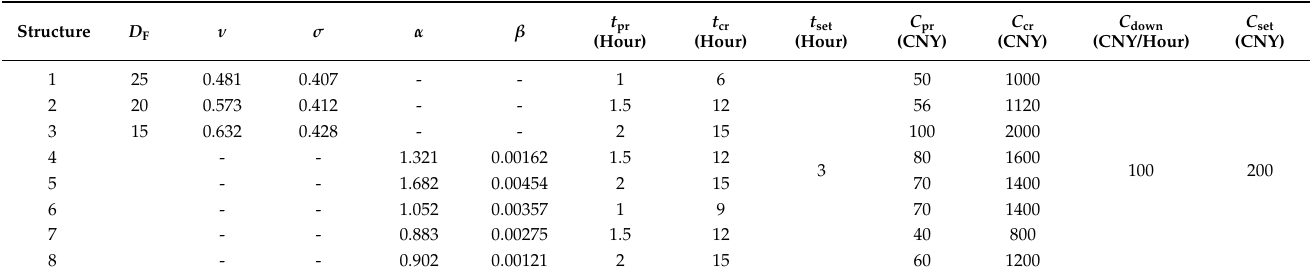
Table 1. Degradation and failure parameters and maintenance cost of all structures.